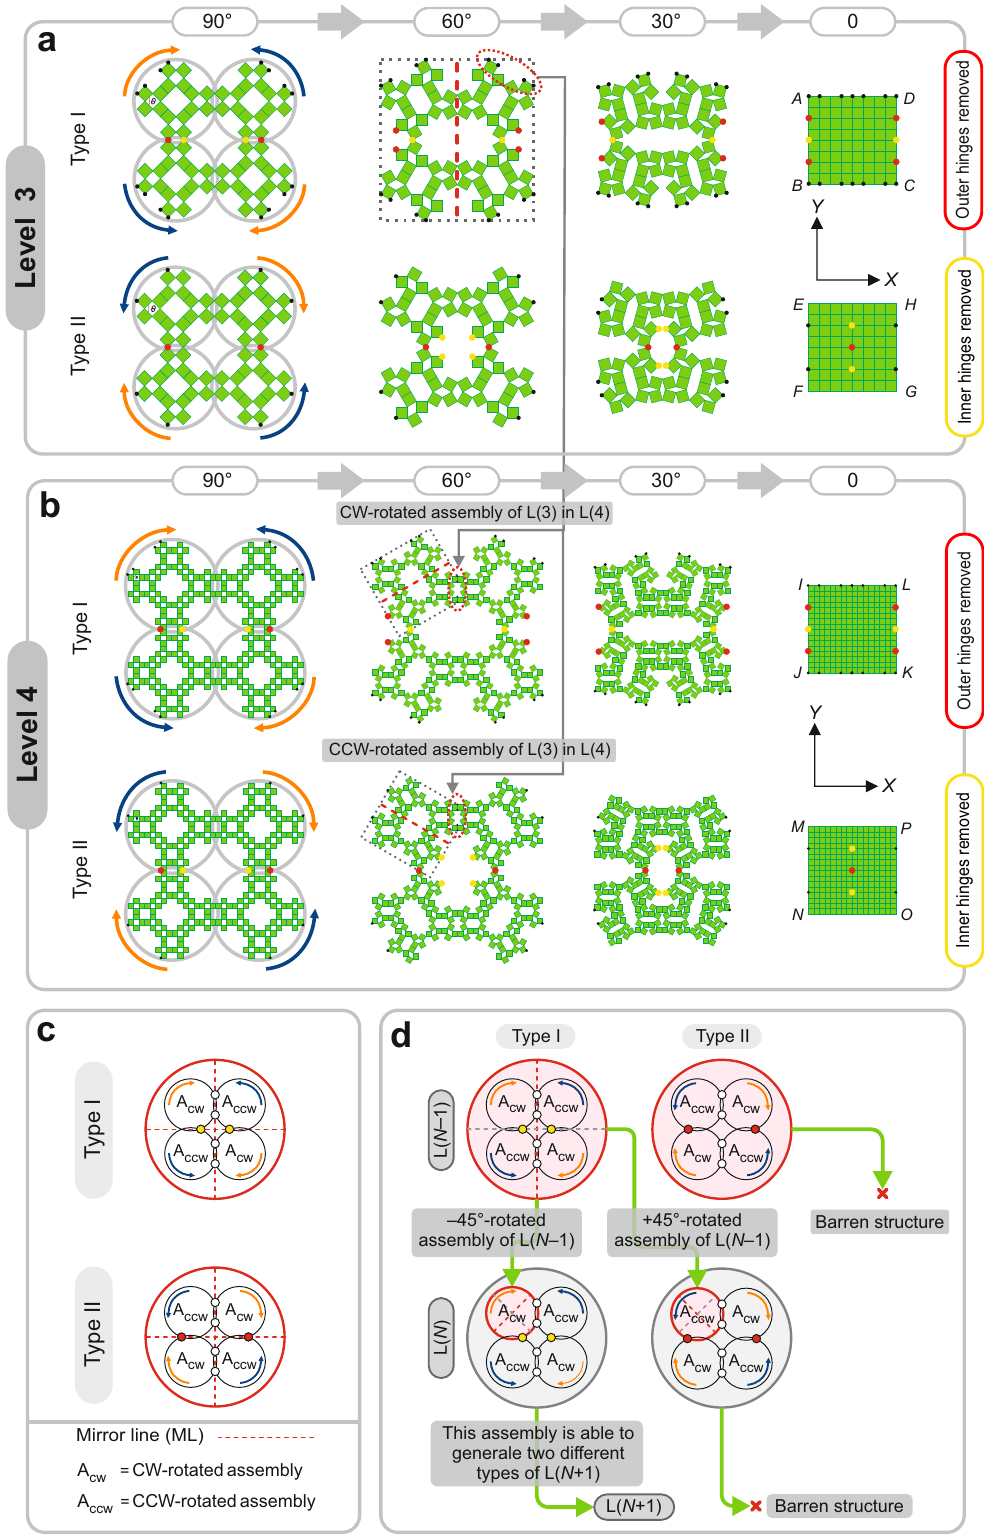
Fig. 2 The generation fl owchart of hierarchical even-numbered assemblies (ENAs). Contraction phases of a level-3, and b level-4 assemblies of Types I and II (in the fi gures, L( N ) denotes level N ). c Representations of Type-I and Type-II assemblies of level N , where the CW- and CCW-rotated assemblies are indicated by A CW and A CCW , respectively. d Generalized generation fl owchart of ENAs. To generate the next levels of the hierarchy, only Type-I assemblies of the previous levels can be used, because all Type-II assemblies are